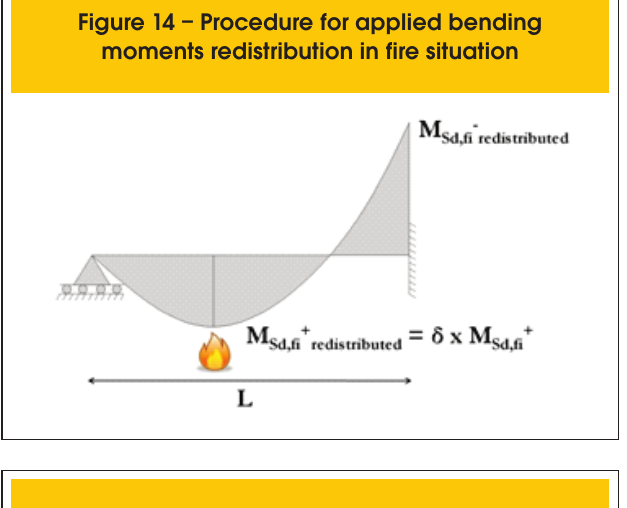
Figure 18 – Determination of the negative time of fire resistance (TRF) of the beam under study by graphic